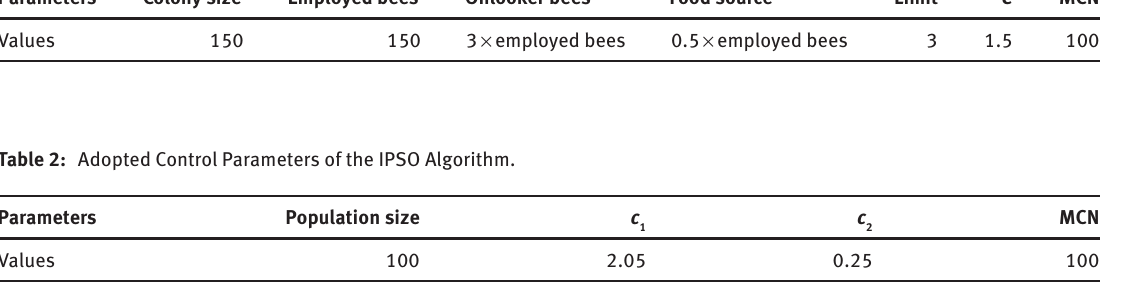
Table 1: Adopted Control Parameters of the GABC Optimization Algorithm. Parameters